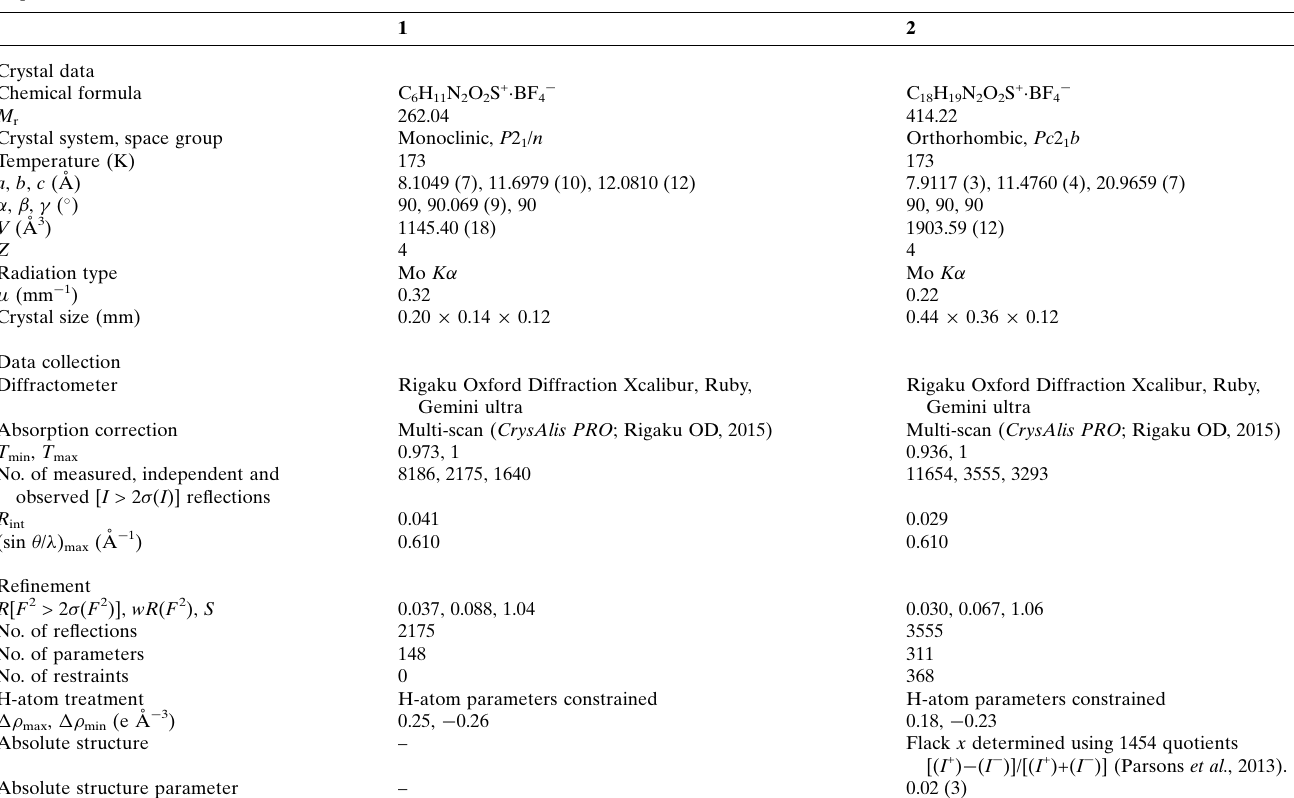
Table 3 Experimental details.